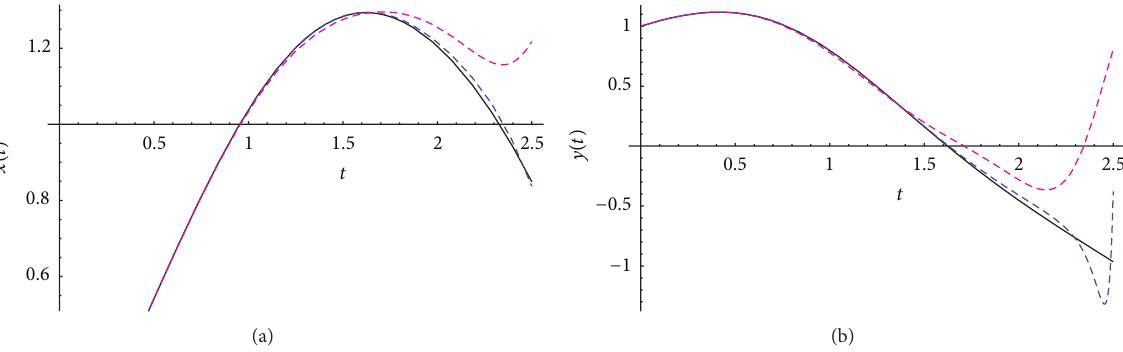
Figure 2: Simulation of the approximate results for 𝛼 = 1 and exact solution of the Van der pol